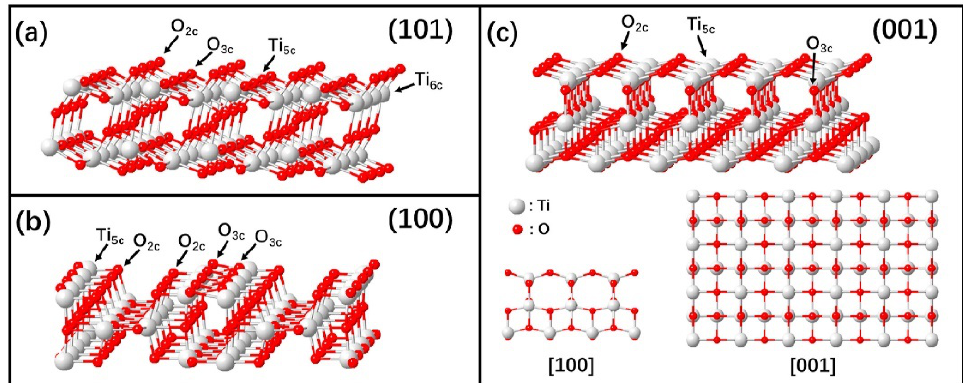
Figure 1. Ball and stick models of anatase TiO 2 low-index surfaces: ( a ) (101) surface; ( b ) (100) surface, and ( c ) (001) surface (red: oxygen; grey: titanium). (taken with permission from [28]).